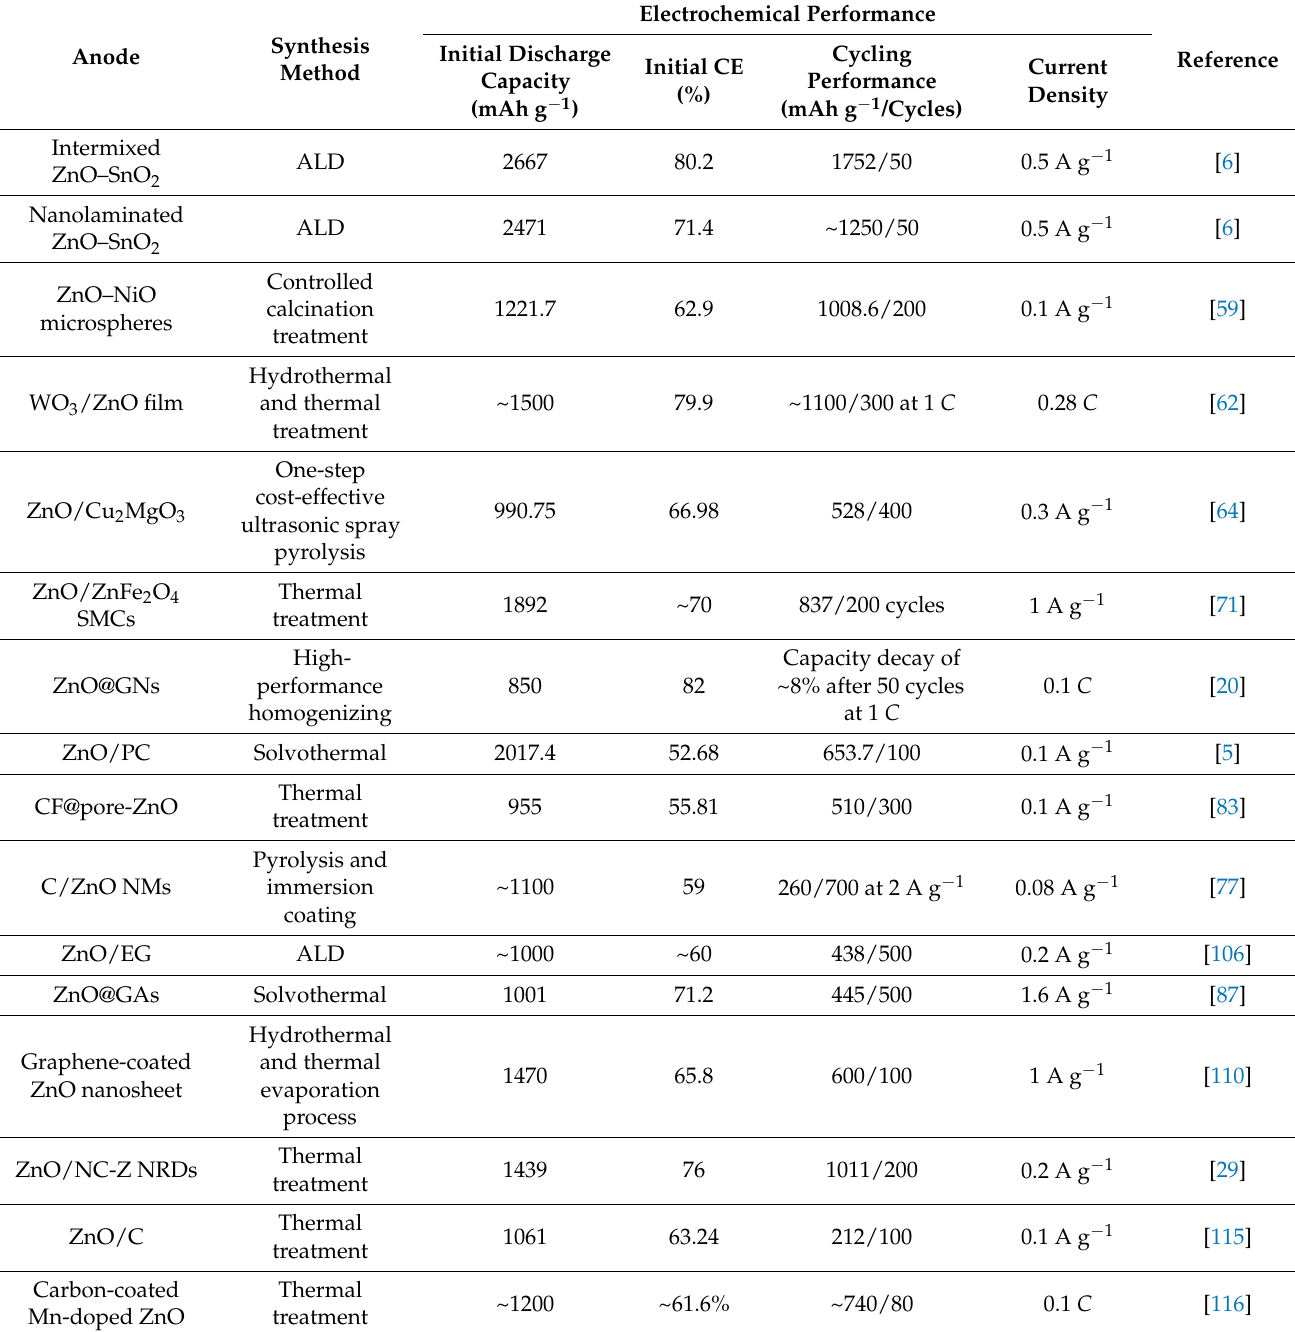
Table 2. Summary of highlighted ZnO binary composite